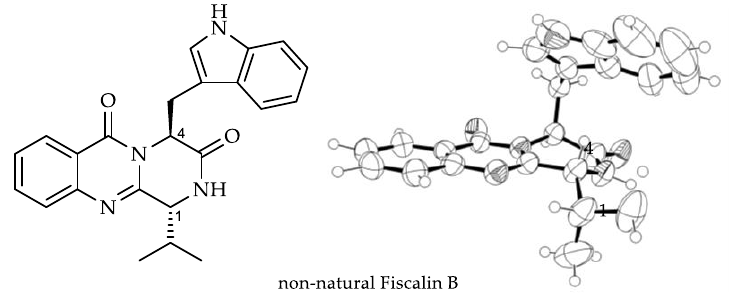
Figure 2. Structure of non-natural fiscalin B (1 R ,4 S )- 1 with the Ortep view.